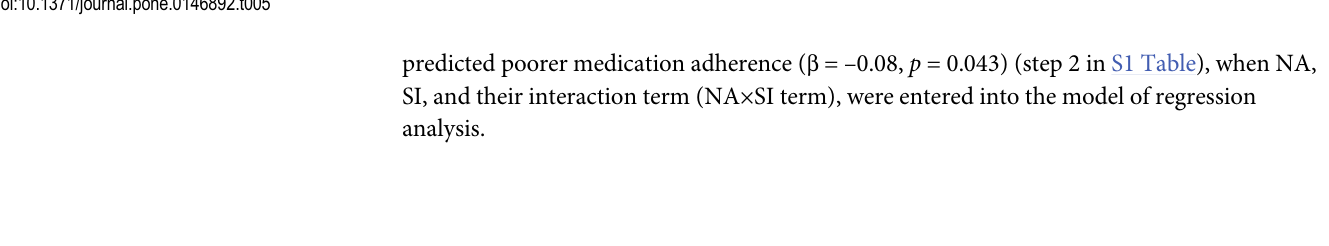
predicted poorer medication adherence ( β = – 0.08, p = 0.043) (step 2 in S1 Table), when NA, SI, and their interaction term (NA×SI term), were entered into the model of regression analysis.